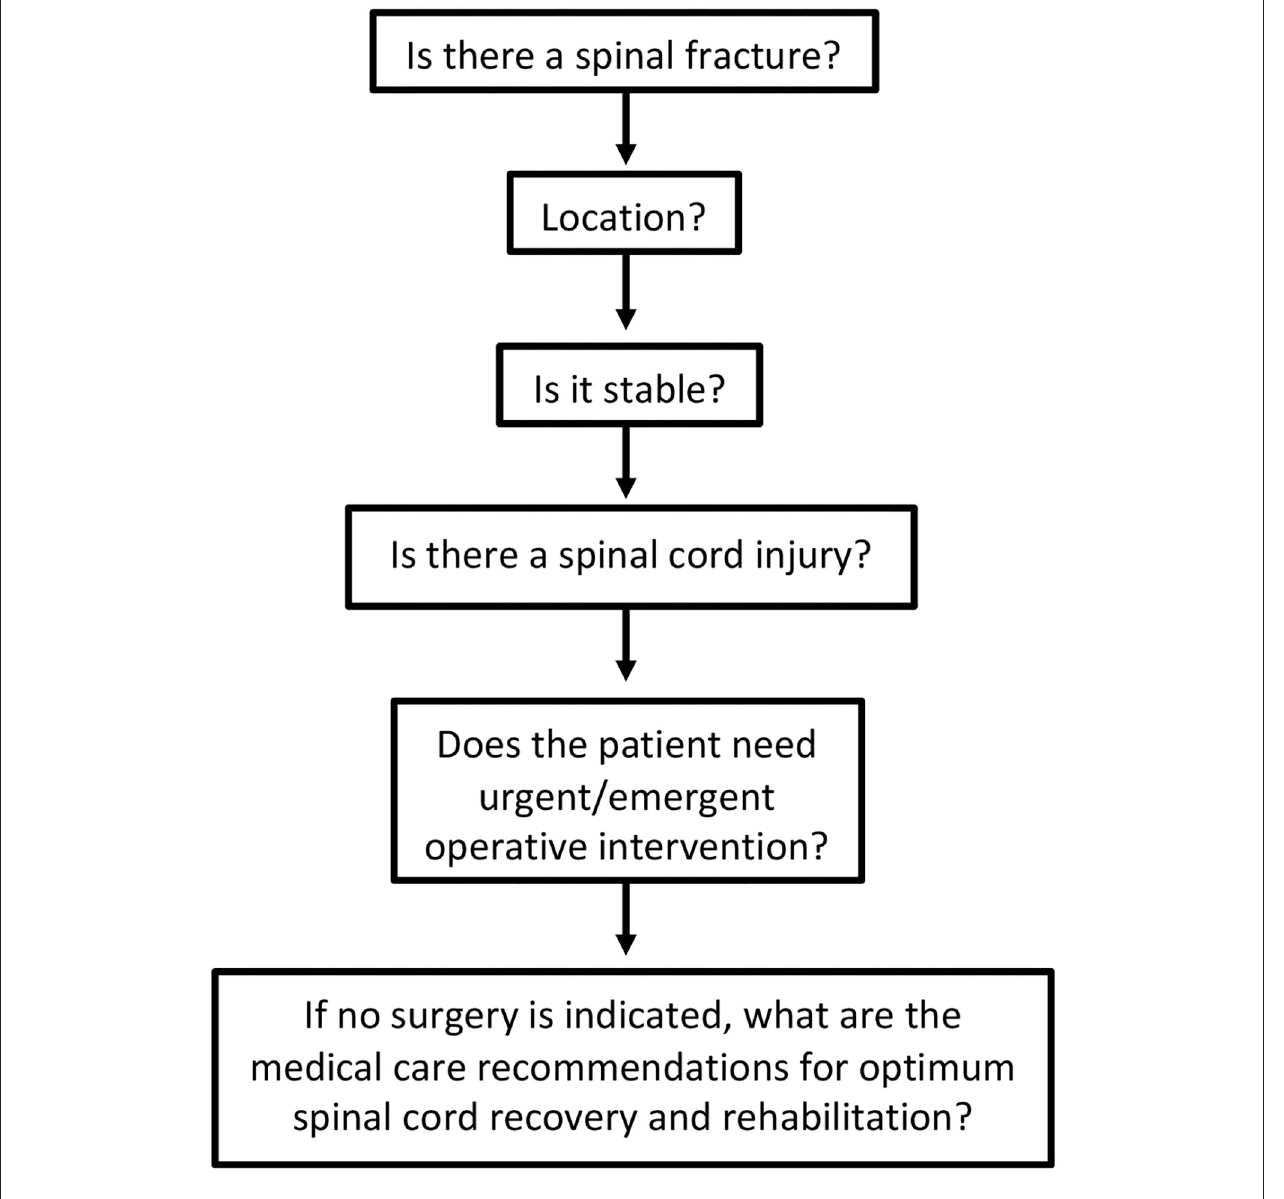
FIGURE 1 | Evaluation process of spinal cord